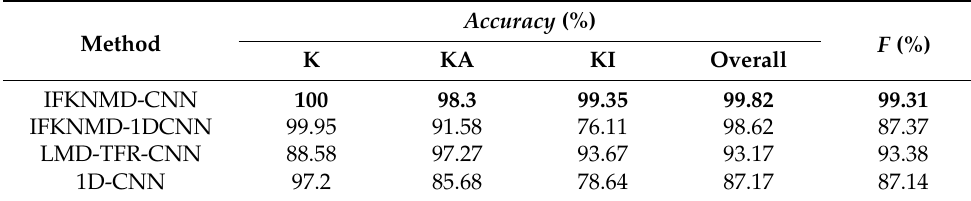
Table 5. Comparison results with deep learning methods.